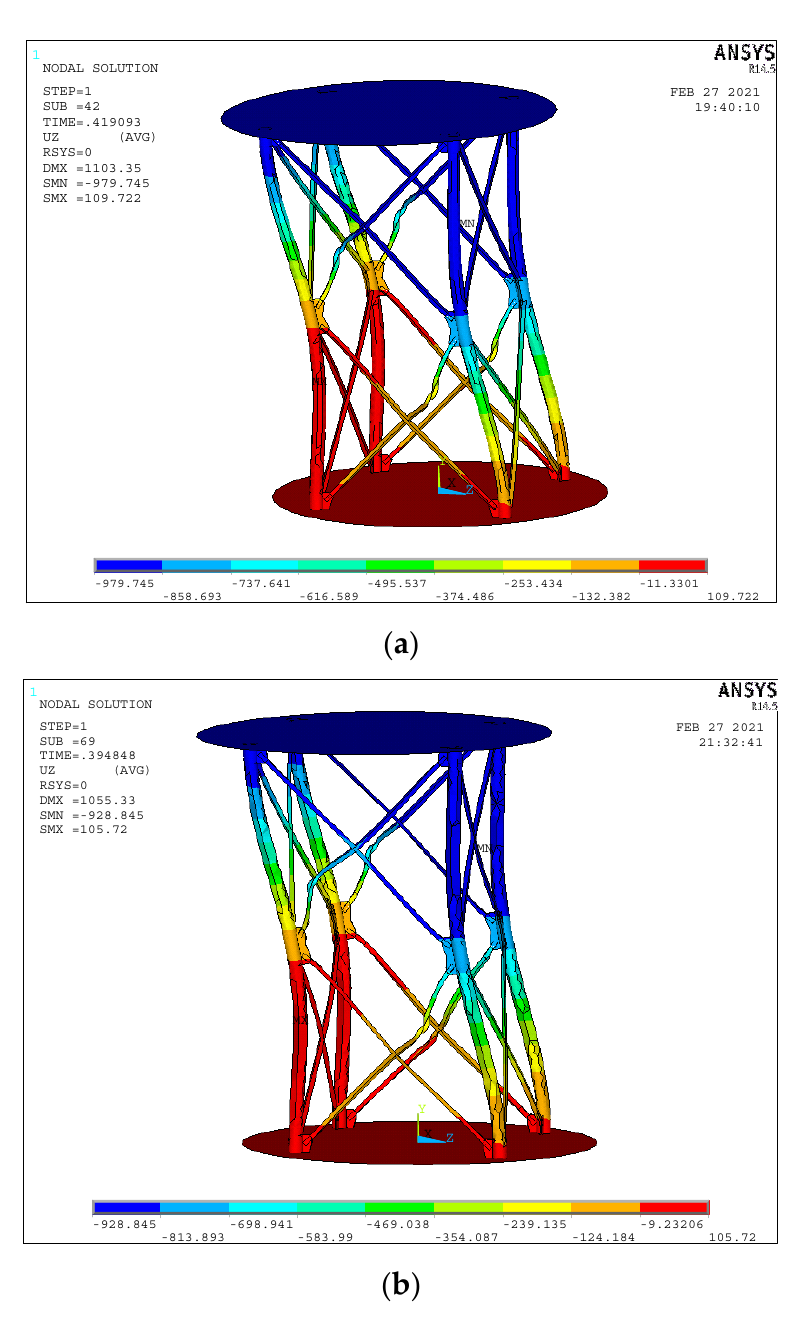
Figure 17. ( a ) Load bearing capacity and horizontal Z displacement of SLSPJ; ( b ) load bearing capacity and horizontal Z displacement of DLDPJ.